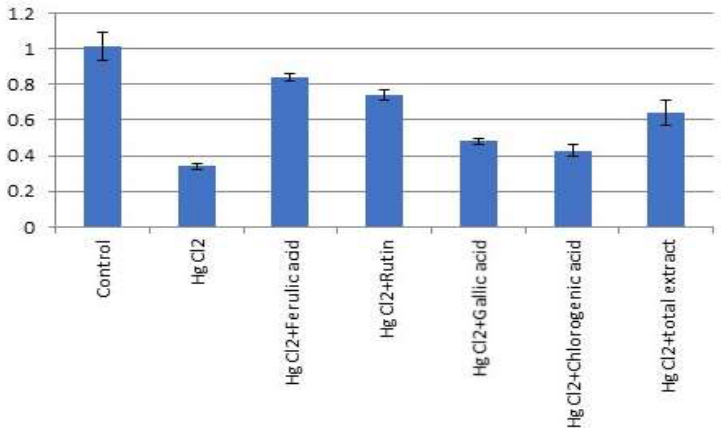
Figure 7. Effect of P. dioica aqueous extract and its isolated bioactive compounds on lung miRNA 21-3p expression in rats. Data ( n = 10 per group) are presented as fold of control considering the normal control one.